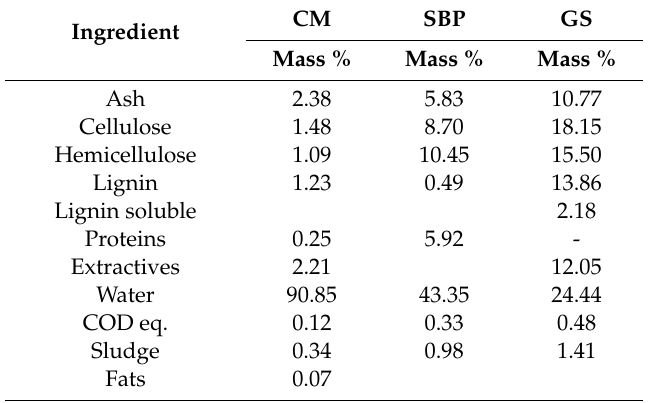
Table 6. The composition of the digestate (wet weight) from anaerobic digestion of CM, SBP, and